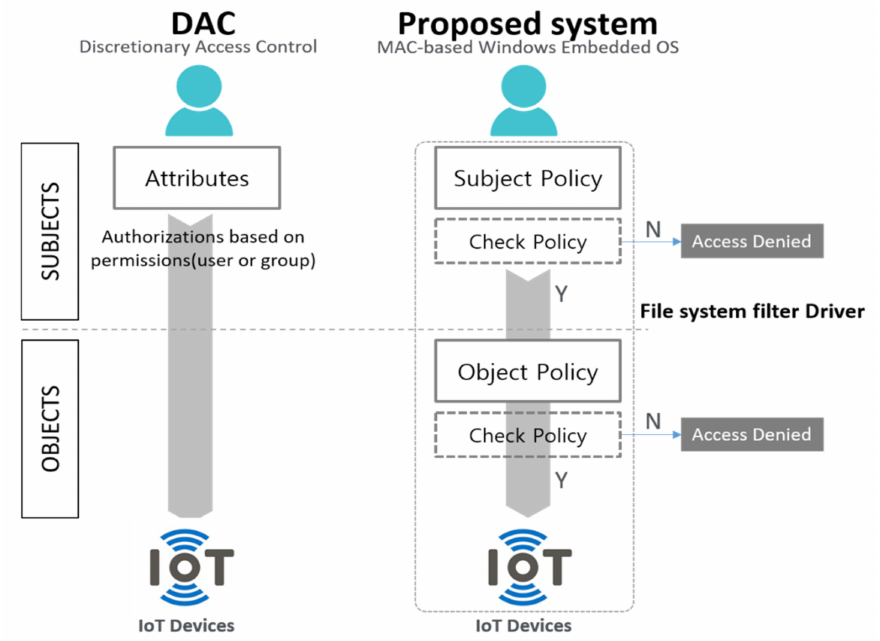
Figure 13. DAC-based whitelist security system.